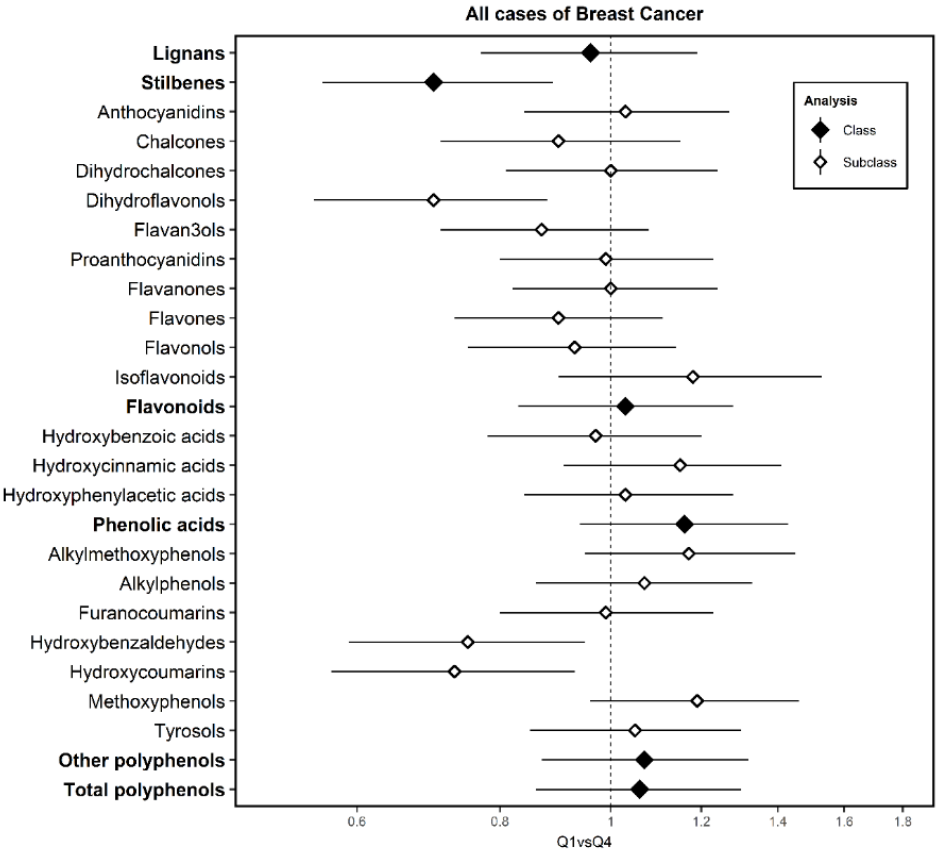
Figure 2. Adjusted Odds Ratios (ORs) of Quartile 4 (Q4) vs. Quartile 1 (Q1) and 95% confidence intervals (CI) of breast cancer according to polyphenol intake in the multi-case-control (MCC)-Spain study. Adjusted ORs of Q4 vs. Q1 and 95% confidence intervals (CI) of BC according to polyphenol intake. ORs were adjusted for age, socioeconomic status, BC family history, body mass index, smoking, physical activity, energy, NSAIDs, age of menarche, number of children, past alcohol intake, hormone replacement therapy and oral contraceptives consumption as fixed e ff ects and province of residence as a random e ff ect